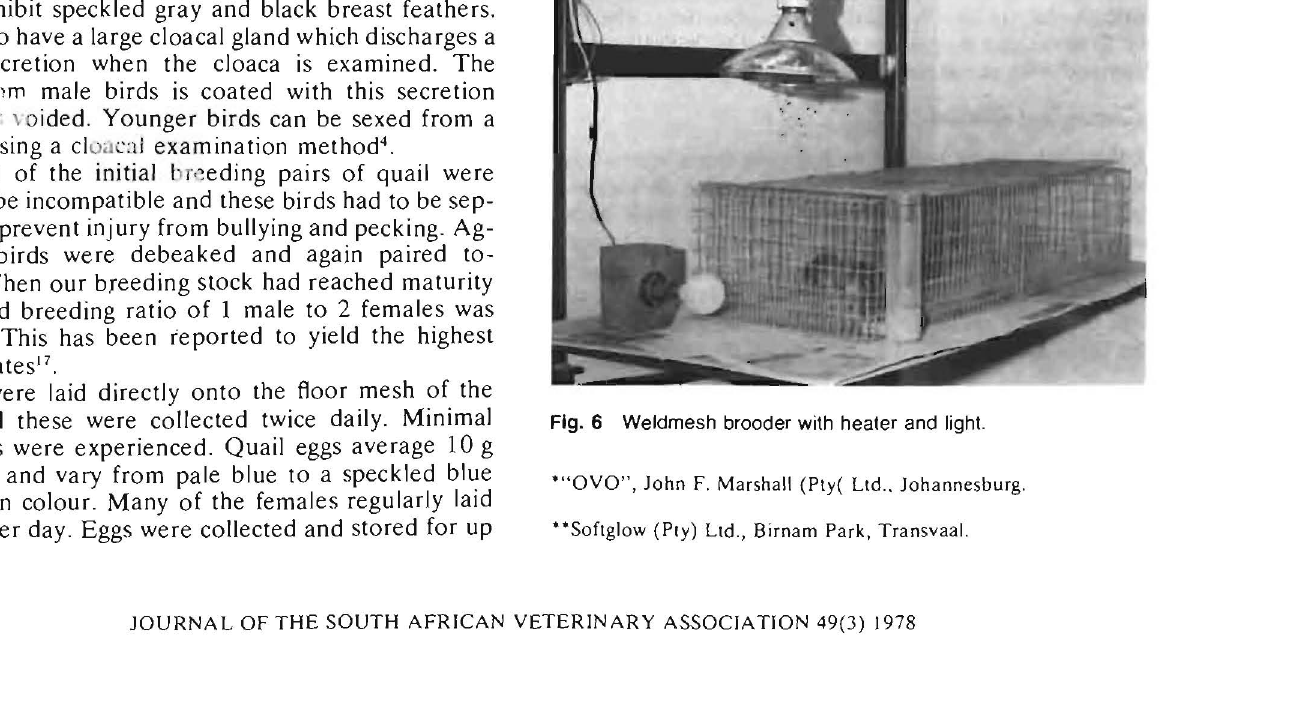
Fig. 6 Weldmesh brooder with heater and